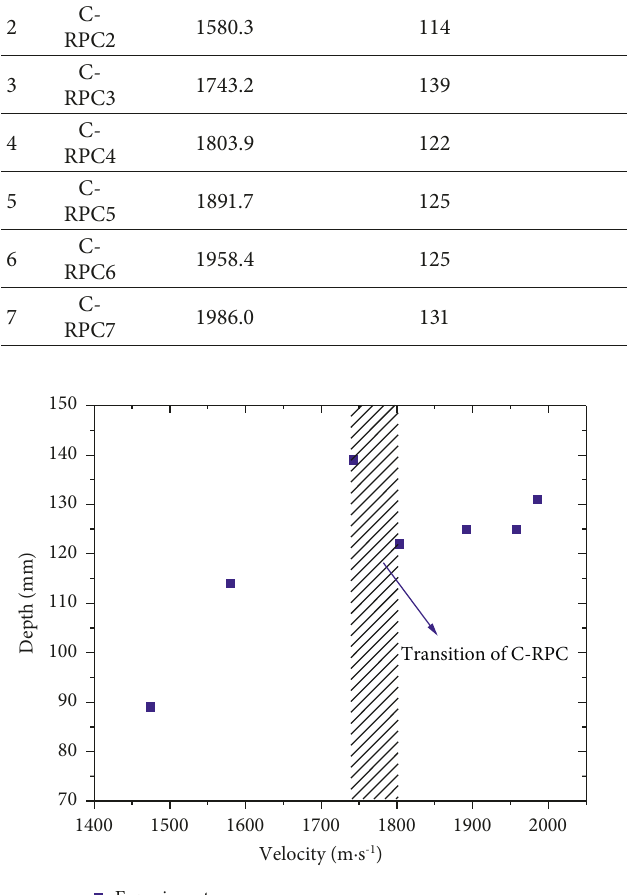
Figure 5: The relationship between the penetration depth and penetration